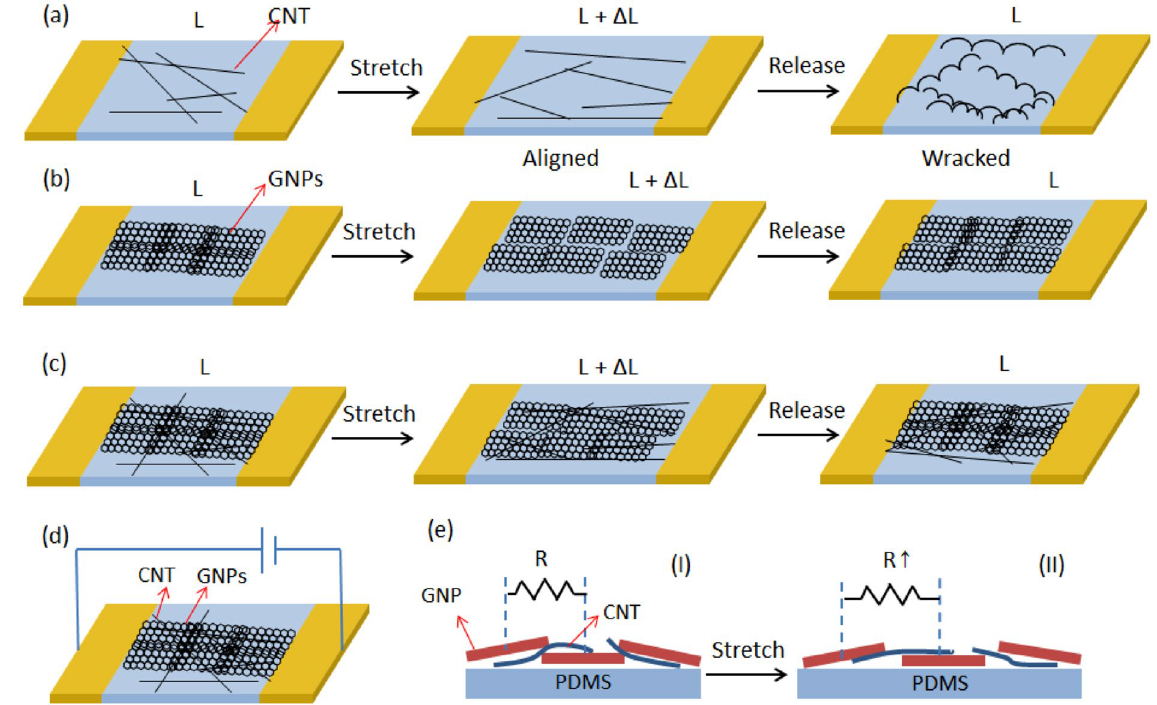
Figure 2. Mechanism of CNTs-enhanced mechanical properties in GNPs network in comparison with the respond of pristine CNTs and pristine GNPs network to repeated mechanical load. Schematic illustration of the microstructural evolution of CNTs ( a ) and GNPs ( b ) and GNP-CNT hybrid ( c ) under stretch and release. ( d ) Measurement scheme of strain sensor based on GNP-CNT hybrid. ( e ) Cross-section of GNP-CNT hybrid sensor, showing stacking GNPs and CNPs before ( e I ) and after ( e II ) stretching. Resistance between conductive elements increases after stretching as the disconnections of GNPs and CNTs